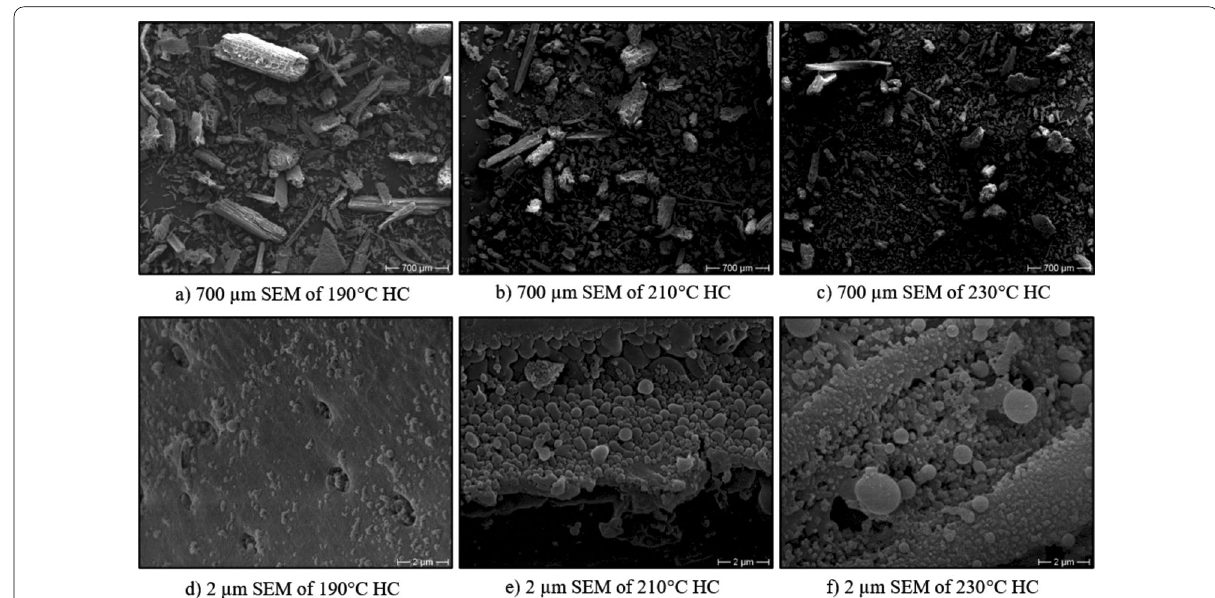
Fig. 1 Scanning electron microscope (SEM) micrographs taken at 700 µm (top row images: a – c ) and 2 µm (bottom row images: d – f ) of the hydrochars produced at increasing HTC